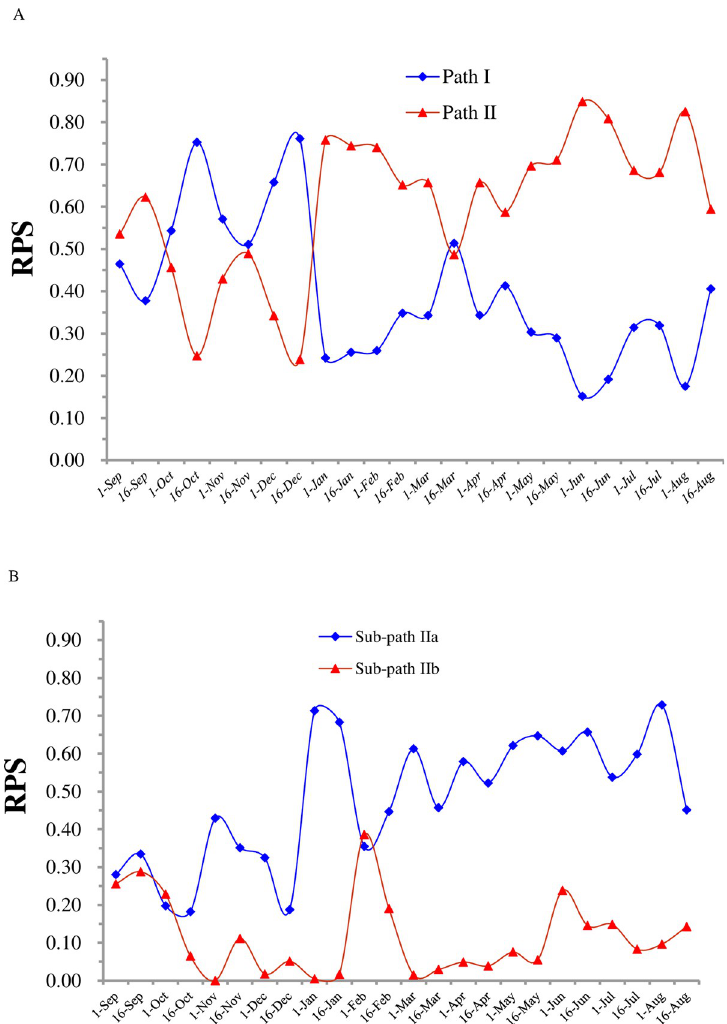
Fig 4. Reaction path selectivity (RPS) of flavonnoidbiosynthesis in T . hemsleyanum and their seasonal variations. (A) Path I: producing Ap, IsoO and Or; Path II: producing Km, Qu, IsoQ, Rut, Ast and Km3rut; (B) Sub-path IIa: producing Qu, IsoQ and Rut; Sub-path IIb: producing Ast and